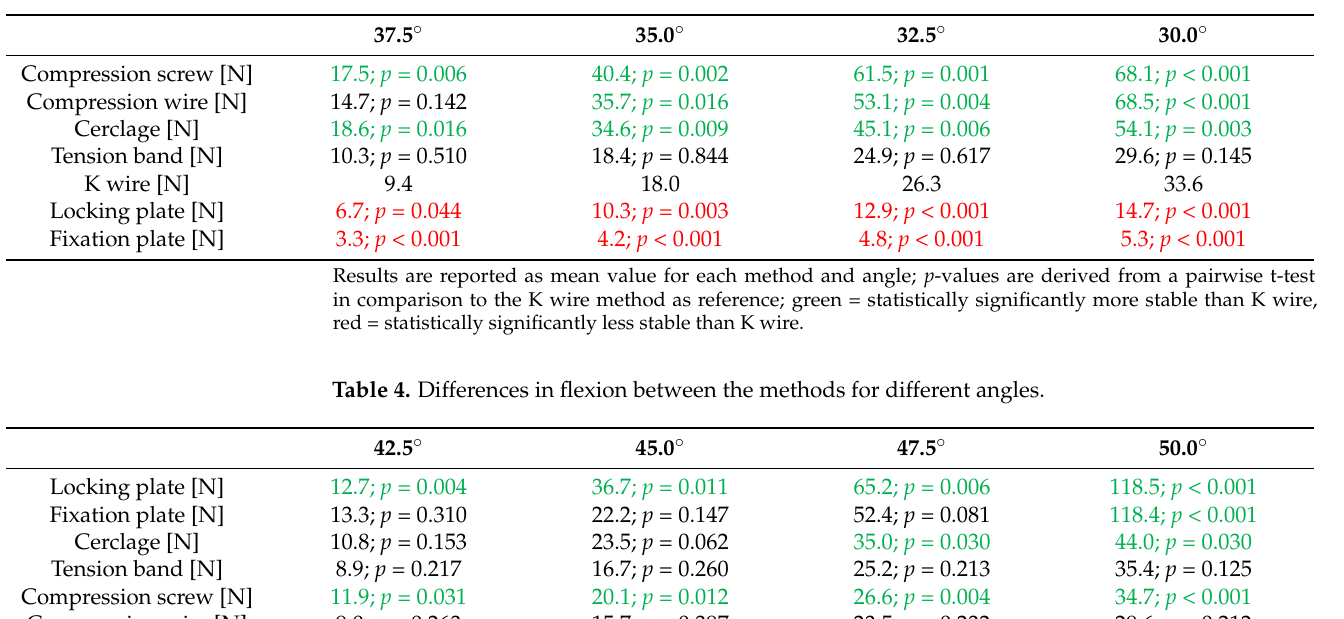
Table 3. Differences in extension between the methods for different angles.